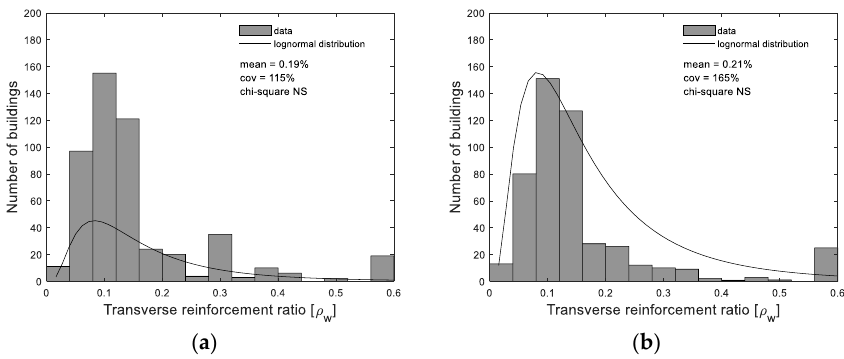
Figure 20. Distribution of buildings regarding transverse reinforcement ratio (%) for ( a ) edge beams and ( b ) interior beams for all RC buildings.